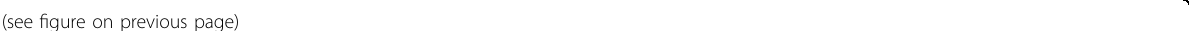
Fig. 1 Potent antibody response to Omicron BA.2, BA.2.12.1, BA.2.75, and BA.5 subvariants by Omicron BA.2 and Delta bivalent LNP- mRNA. a Vaccine design of Omicron BA.2 and Delta variant-speci fi c LNP-mRNA based on BA.2 and Delta spike mutations. Unique spike mutations on BA.2.12.1, BA.2.75, and BA.5 (not included in LNP-mRNA) are colored in orange, green, and red. b Distribution of BA.2 (purple), BA.2.12.1(orange), BA.2.75 (green), and BA.5 (red) mutations in one protomer of Omicron spike trimer (PDB: 7T9K). c Delta- and BA.2-speci fi c monovalent or bivalent LNP-mRNA boosters improved antibody response of WT-vaccinated mice to Omicron BA.2, BA.2.12.1, and BA.4/5 subvariants. Comparison of binding antibody titers against BA.2, BA.2.12.1, and BA.4/5 spike RBD and ECD before (D28) and after (D42) receiving 1.5 µg WT-, Delta-, BA.2-speci fi c monovalent or bivalent (1.5 µg Delta + 1.5 µg BA.2) LNP-mRNA boosters. Antibody titers were quanti fi ed by area under curves (AUC) of ELISA response curves in Supplementary Figs. S1 and S2. Blood samples were collected in mice immunized with two doses of 1.5 µg WT LNP-mRNA followed by 1.5 µg WT-, Delta-, BA.2-speci fi c monovalent or Delta & BA.2 bivalent boosters ( n = 6 in each group). d Neutralization of Omicron BA.2, BA.2.12.1, BA.2.75, and BA.5 pseudovirus by plasma of mice before (D28) and after (D42) vaccination with WT-, Delta-, BA.2-speci fi c monovalent or Delta & BA.2 bivalent boosters. Six samples collected on day 0 were included and compared to both D28 and D42 datasets. e Neutralization of Omicron BA.2.12.1 and BA.5 authentic virus by plasma of mice before (D28) and after (D42) vaccination with WT-, Delta-, BA.2-speci fi c monovalent or Delta & BA.2 bivalent boosters. Six samples collected on day 0 were included and compared to both D28 and D42 datasets. The authentic virus neutralization assay was blinded. Titer ratios before and after receiving boosters (D42/D28 ratios) were shown in Fig. 1c ‒ e. Titers in Fig. d , e are log 10 transformed. Statistical analysis details can be found in supplementary